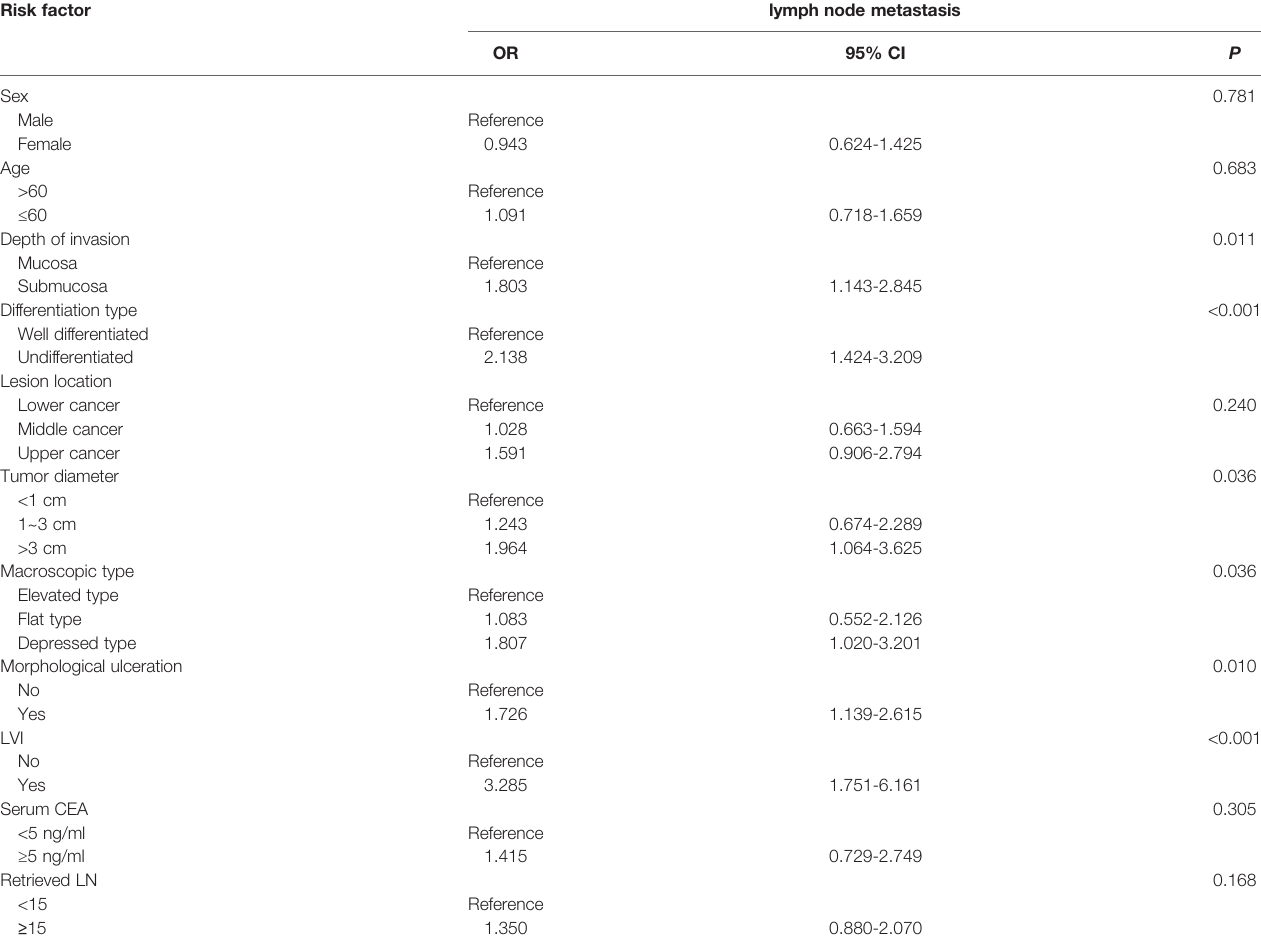
TABLE 4 | Univariate analysis of lymph node metastasis and clinicopathological factors in EGC. Risk factor